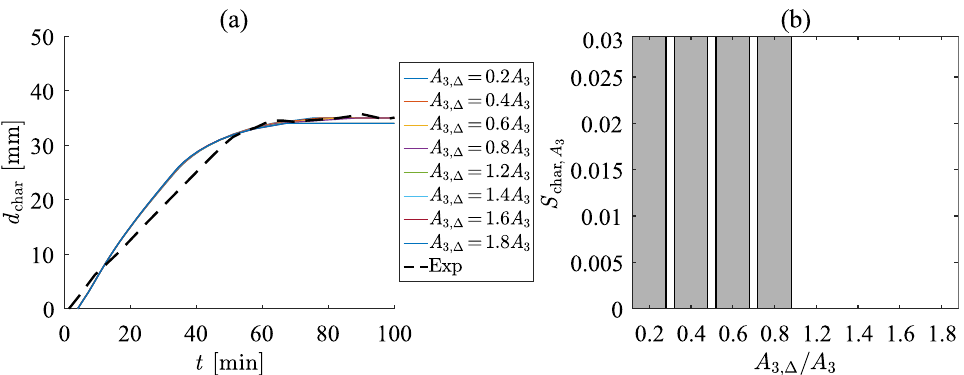
Fig. 7 a The development of charring depth for varied parameter A 3, (cid:31) . b Sensitivity index S char, A final charring